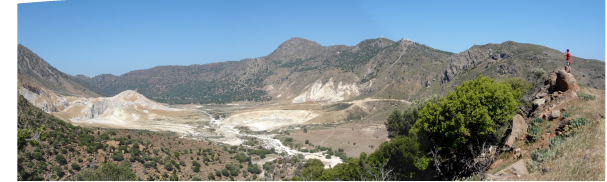
Fig. 2. Panoramic image towards the NE showing the caldera floor (the Laki plain) and the hydrothermally active area as well as the exposed caldera wall. The phreatic Stefanos crater is located in the centre together with other phreatic craters and domes to its left. Post-caldera dacitic domes mark the left border of the image. The width of view is about